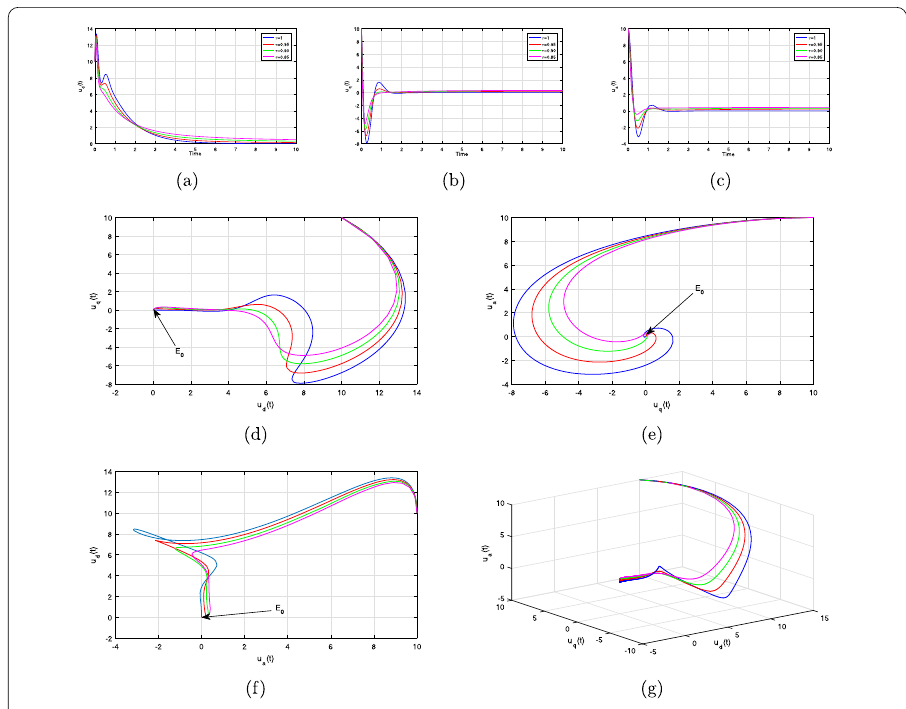
Figure 5 Simulations of Example 4 for time-fractional brushless DC motor (10) in the Liouville–Caputo sense